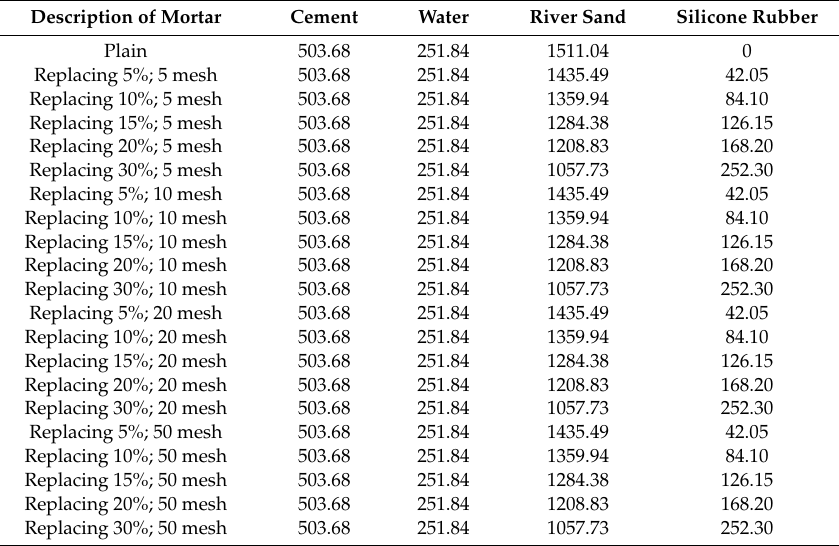
Table 2. The detailed mix proportions of mortar in the first stage test (kg/m 3 ).